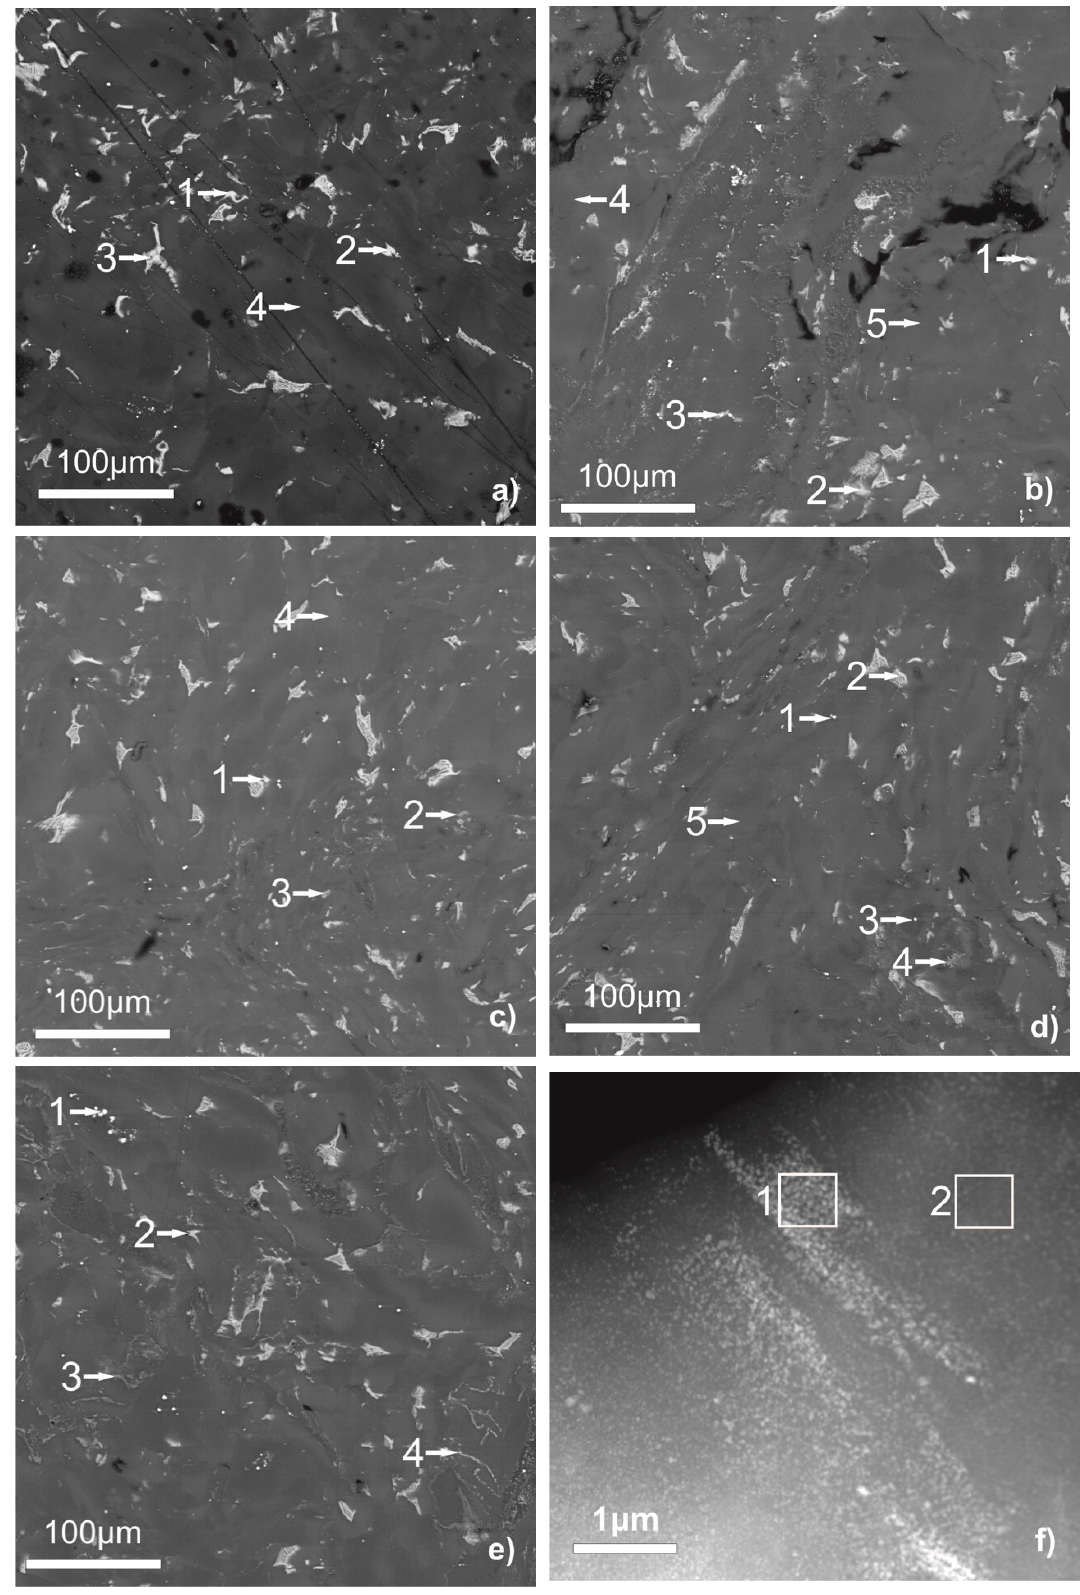
Figure 1. SEM micrographs of WE43 samples unmodified ( a ) [10], modified with aluminum oxide ( b ), titanium oxide ( c ), magnesium oxide ( d ), and zinc oxide ( e ) after deformation by high-pressure torsion. STEM micrograph of WE43 sample modified with aluminum oxide ( f ).